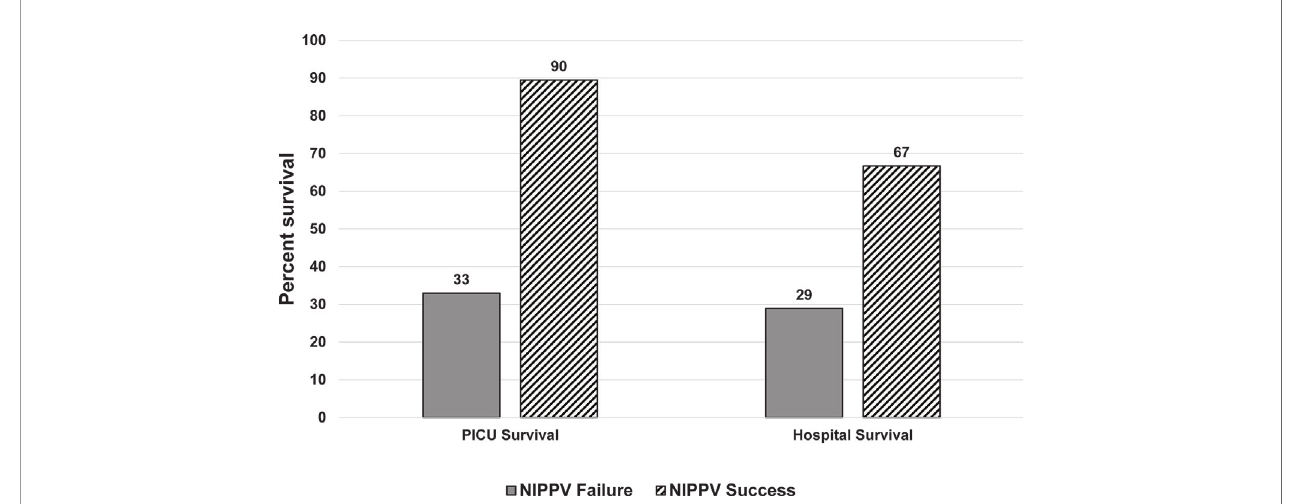
FIGURE 1 | Survival assessed by NIPPV success or failure at PICU and hospital discharge. Those who failed NIPPV, represented by the solid dark gray bars had a poor PICU and hospital survival. Those who were successfully treated with NIPPV, represented by the diagonal black lines, had a high PICU survival but there was a decrease in hospital survival